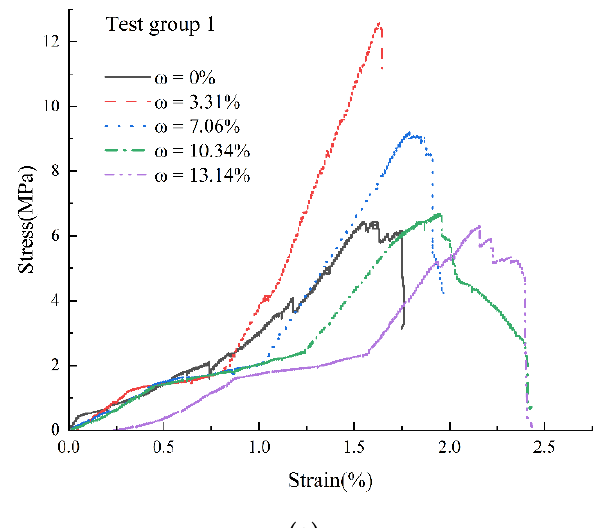
Figure 4. The schematic diagram of the test system.